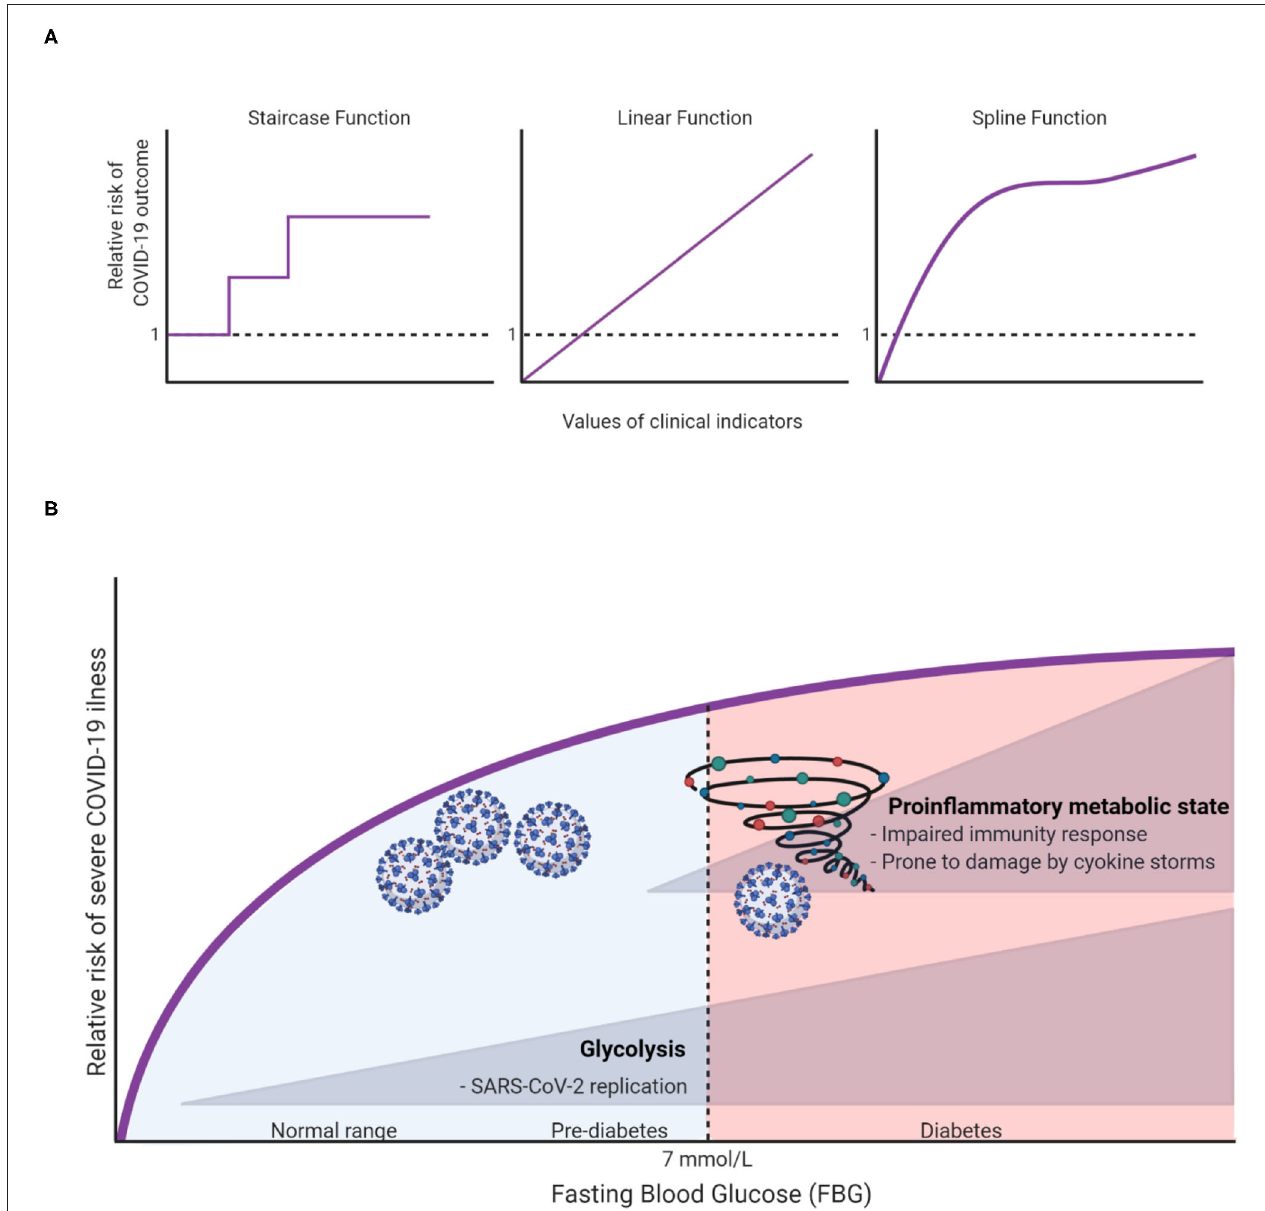
FIGURE 1 | (A) Illustration of different possible dose-response relationships that can be fitted for continuous clinical indicators (e.g., age, fasting blood glucose, body mass index, etc.) to show the risk ratios of COVID-19 outcomes (e.g., hospitalization, ICU admission, or death). (B) A hypothesis on how FBG can affect COVID19